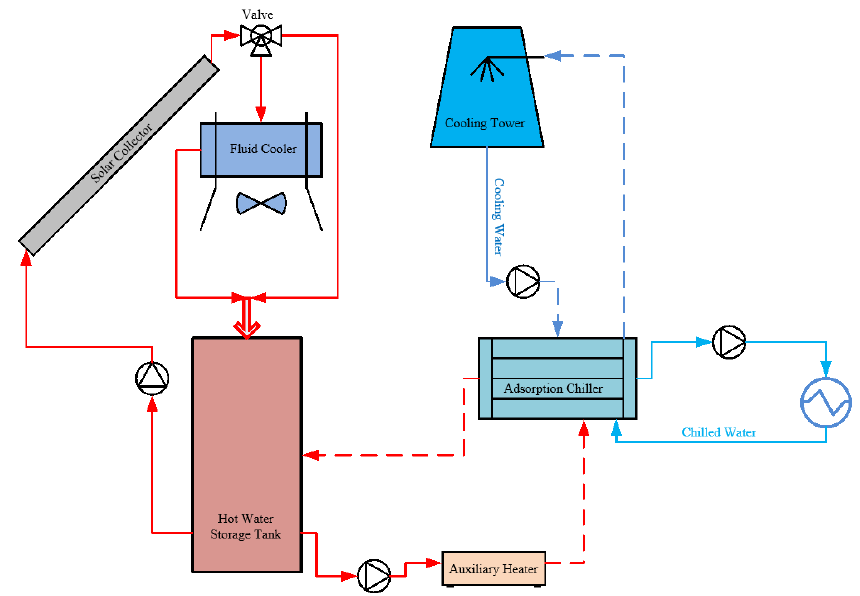
Figure 2. A schematic diagram of a solar adsorption cooling